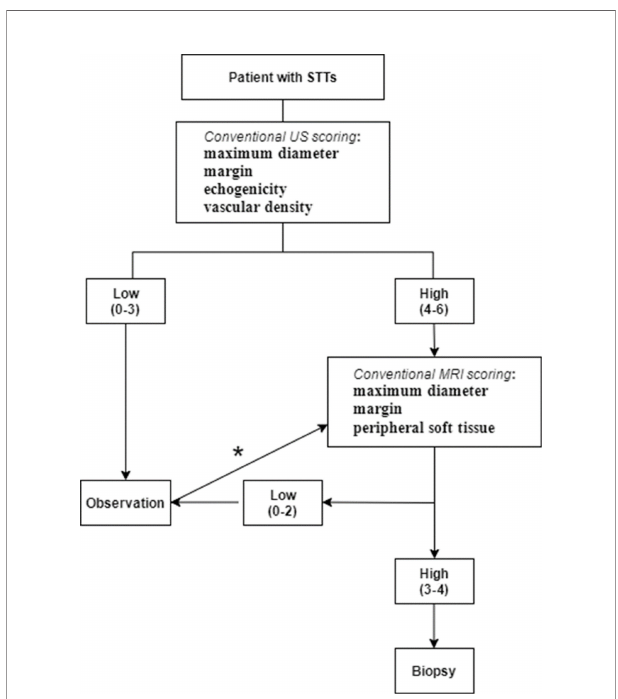
FIGURE 6 | Work fl ow ofthe imaging diagnosisof STTs basedonUSand MRI scoring system. This fl owchart presents a screeningprocedure for STTs. The US score isevaluatedat the fi rst visit. If thescore islow (<3.5 points), the patient can beobserved periodically over several months. If the tumor size increases rapidly or the score increases onthe second visitorlater,the physician may consider performing MRI (*). If the score ishighatthe initial visit( ≥ 3.5 points), MRI may be recommended. When the MRI score isless than 3 points (<2.5 points),a short- termobservation can berecommended,otherwise, itis suspected to be malignant ( ≥ 2.5points).Biopsy should beperformed to obtain a pathological diagnosisfor any mass considered